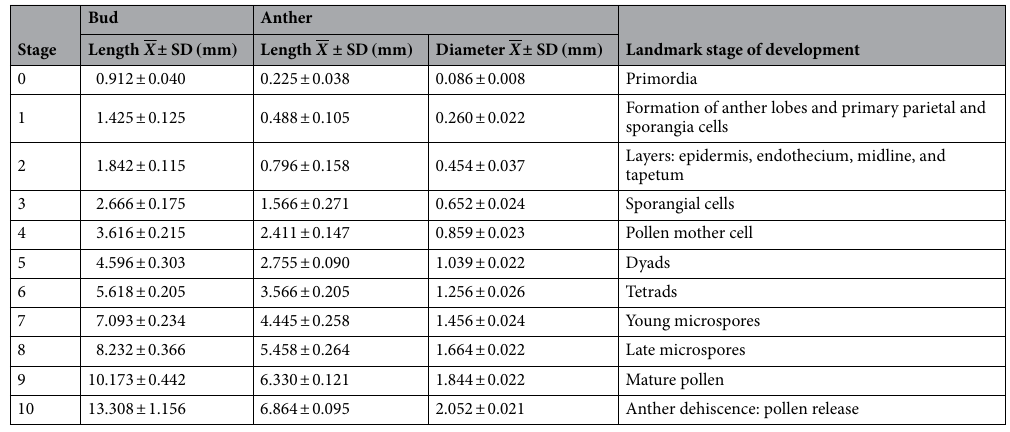
Table 1. Stages of anther and pollen development in diploid potato cultivar Criolla Colombia ( Solanum tuberosum Phureja Group). The results showed significant differences between all the development stages, for length and diameter of buds and anthers, according to Kruskal–Wallis and Dunn’s tests. SD standard deviation.